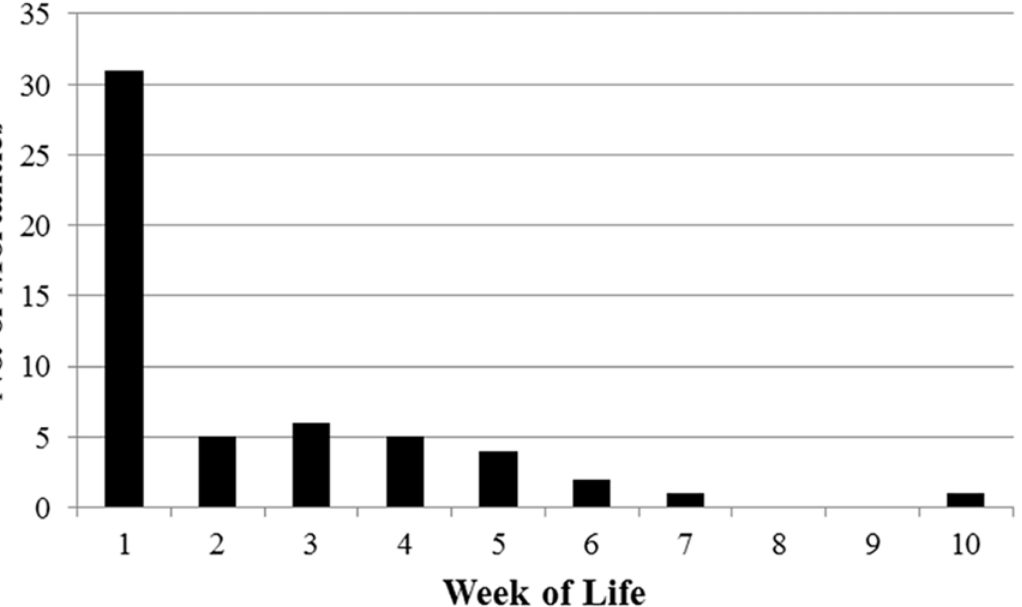
Fig 2. Number of mortalities by week of life among radiocollared neonatal white-tailed deer at Fort Bragg Military Installation, North Carolina, 2011 – 2012.